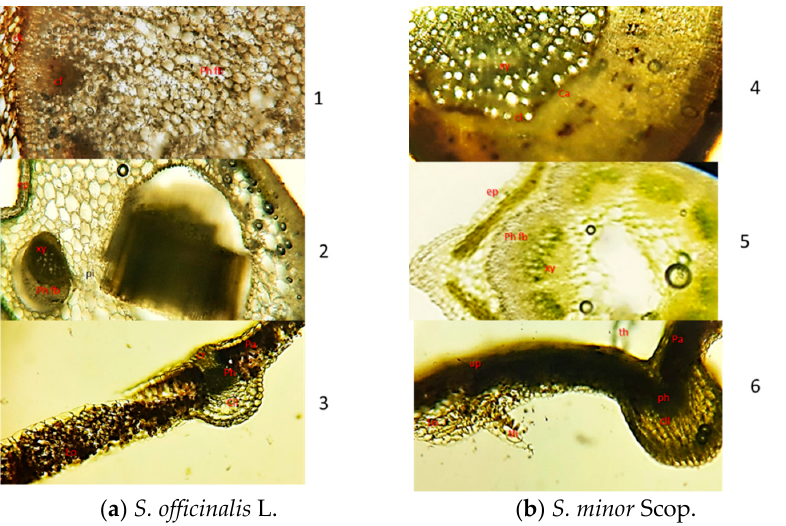
Figure 2. a. Transverse section of different organs of S. officinalis L. ( a1 ) root (SOR); ( a2 ) stem (SOS);